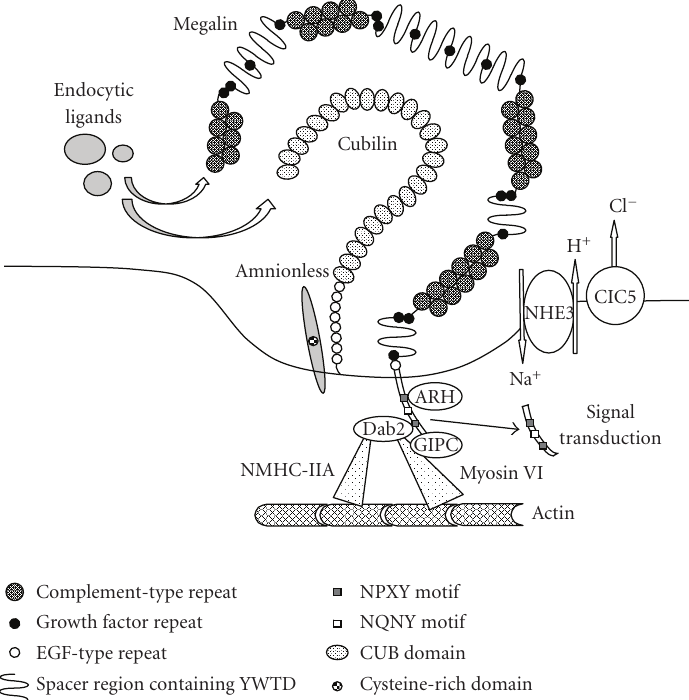
Figure 1: Megalin and its associated molecules involved in receptor-mediated endocytosis in PTEC. On the apical membrane of PTEC, various molecules are involved in the process of receptor-mediated endocytosis. Megalin, playing a central role in the process, cooperates with other membrane proteins such as the cubilin-amnionless complex (CUBAM), NHE3, and ClC5. Megalin and CUBAM directly bind a variety of ligands, whereas NHE3 and ClC5 are involved in endosomal acidification, which is important for further processing of endocytosed proteins. Megalin also interacts with intracellular adaptor proteins such as ARH, Dab2, and GIPC. Dab2 binds to motor proteins, myosin VI, and NMHC IIA, which may mediate endocytic tra ffi cking of the molecular complexes through actin filaments. The cytoplasmic tail of megalin is released from the membrane by γ -secretase and is involved in intracellular signal